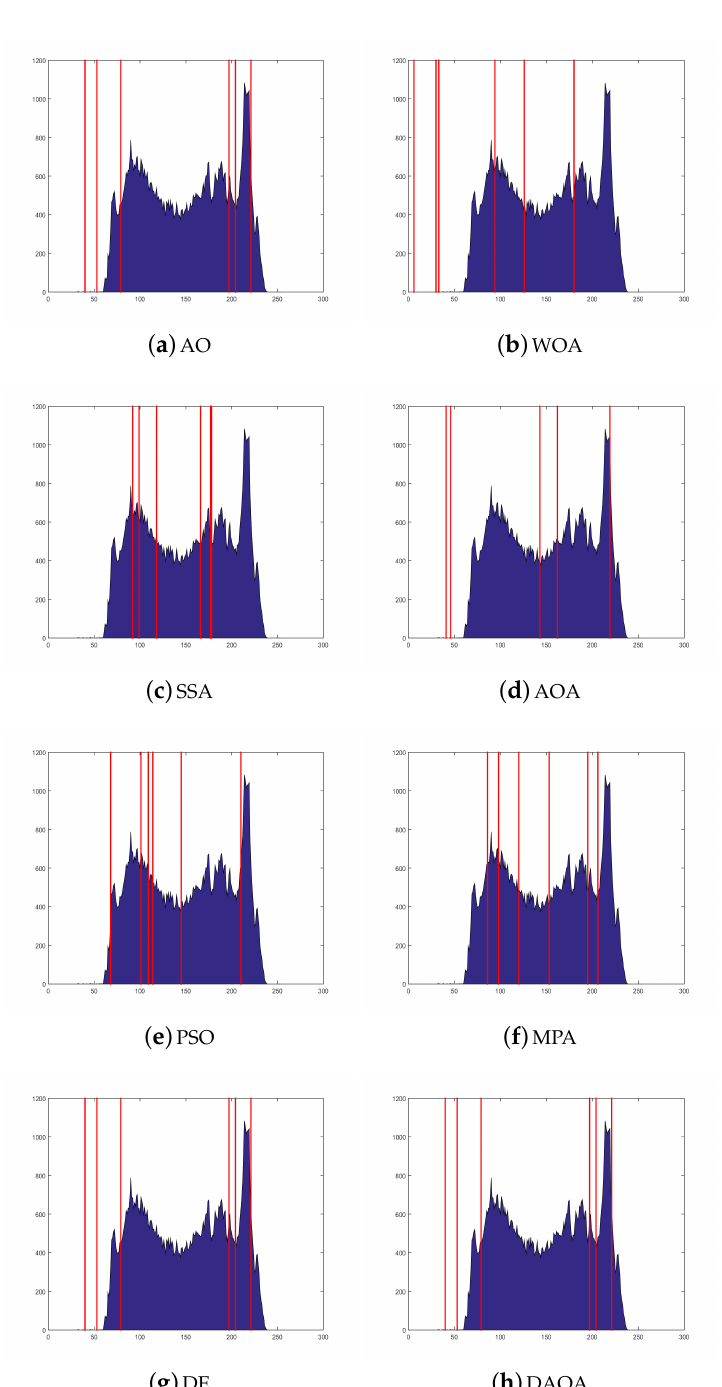
Figure 15. The histogram image (Test 8) by the comparative methods when the threshold value is